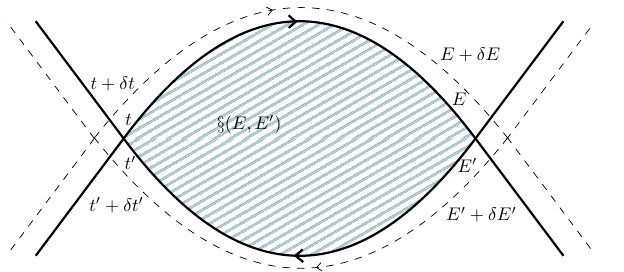
Figure 1. The action § ( E , E (cid:48) ) of the closed compound orbit is the symplectic area between both orbit segments, which coincide with the E -shell and the E (cid:48) -shell if N = 1. It is a smooth function of both energies, as are the times t ( E , E (cid:48) ) and t (cid:48) ( E , E (cid:48) )